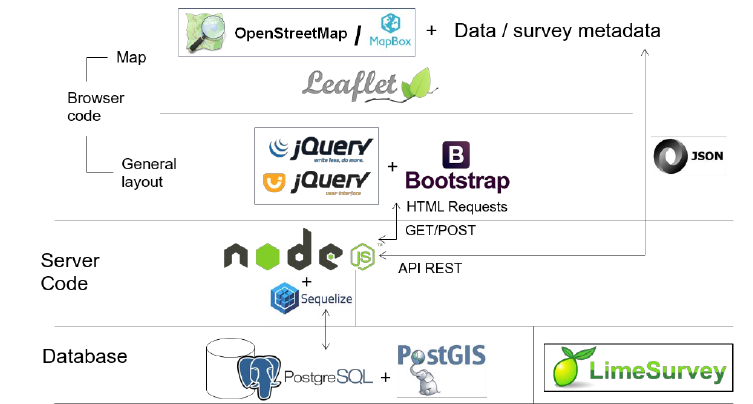
Figure 1. Emapic